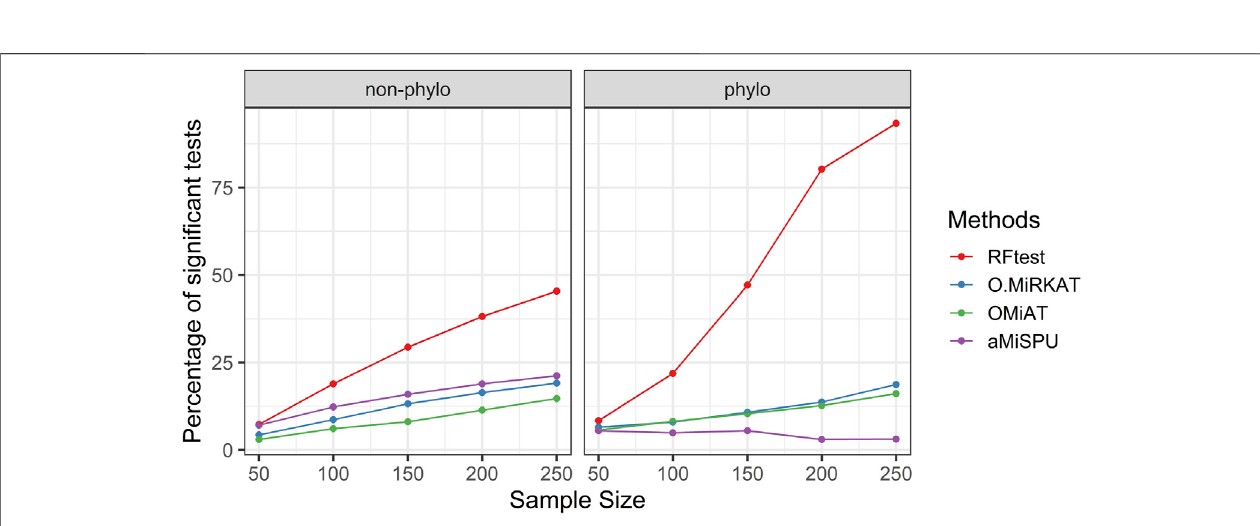
FIGURE 4 | Power comparison among the competing methods when there was interaction between two microbial groups. The outcome variable was binary, and two signal types, phylogenetic and non-phylogenetic, were investigated. The two microbial groups comprised 13% and 15% of the total OTUs.